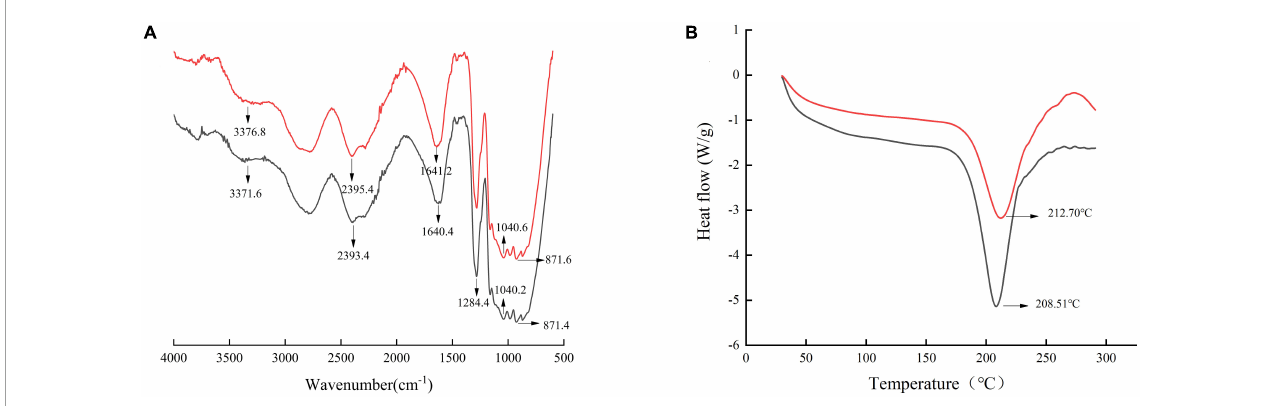
FIGURE4 Fourier transform infrared spectroscopy (FT-IR) (A) and differential scanning calorimetry (DSC) thermogram (B) of soluble dietary fiber (SDF) from adlay bran. [Black line: untreated, red line: treated by steam explosion (SE) at 0.8 MPa, 3 min].